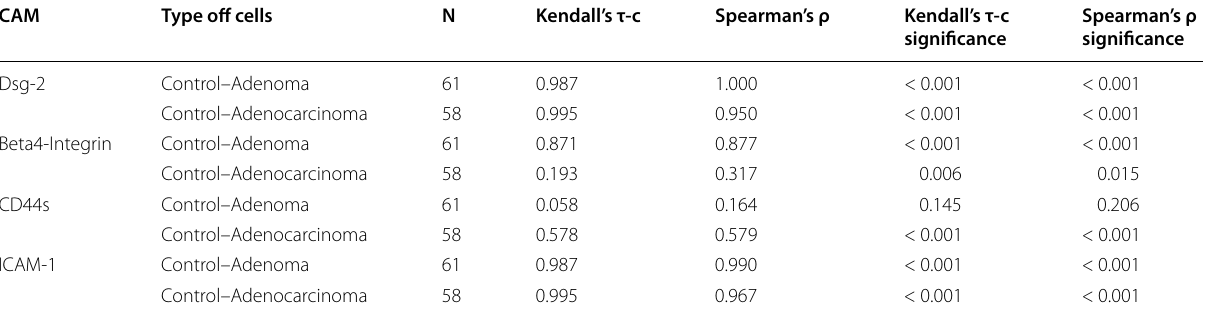
Table 4 Correlation between different kind of cells and Intensity of staining